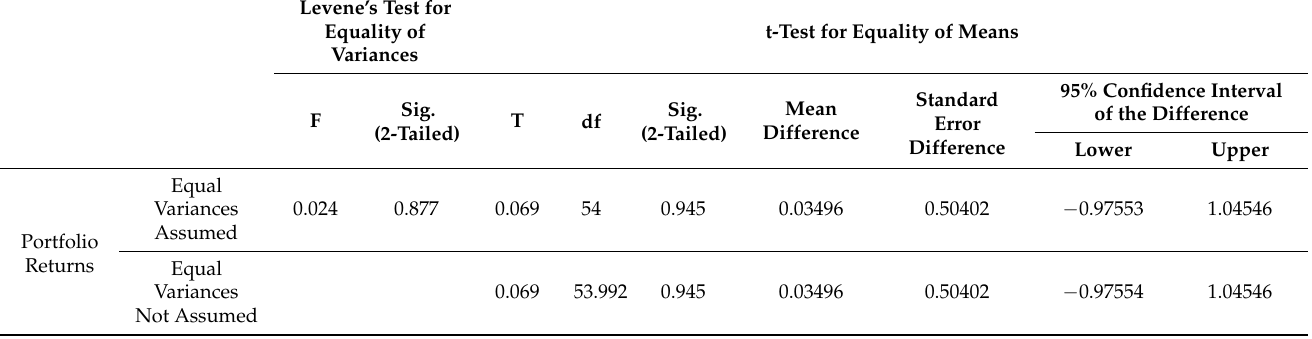
Table 6. Independent samples test for contrarian and value portfolio returns for year t + 2.